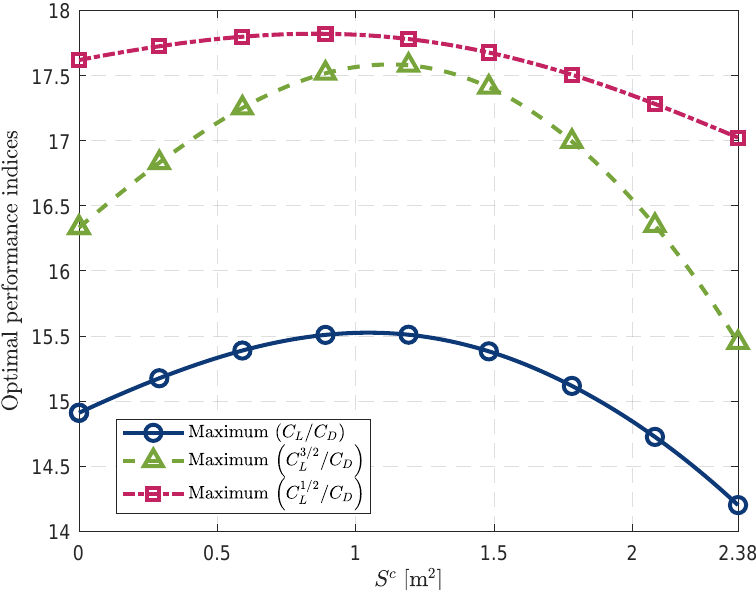
Figure 4. Maximum lift-to-drag ratio as function of the canard surface. Circle markers: analyzed configurations; solid line: spline